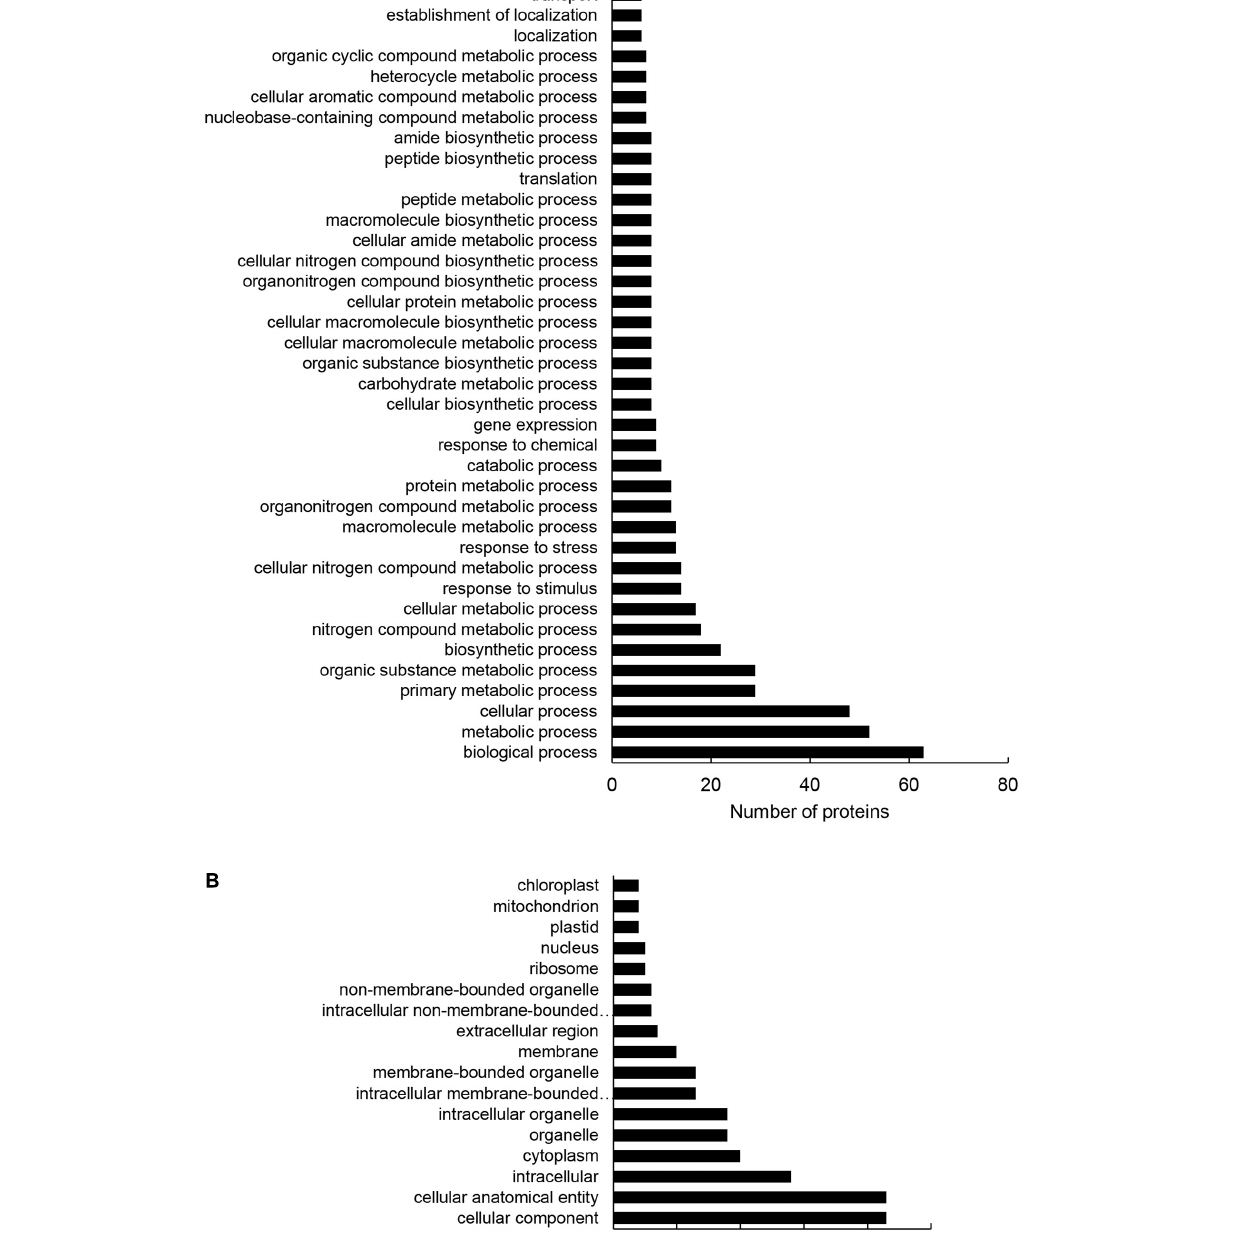
of WT and HvMPK3 KO lines. Six reproducibly